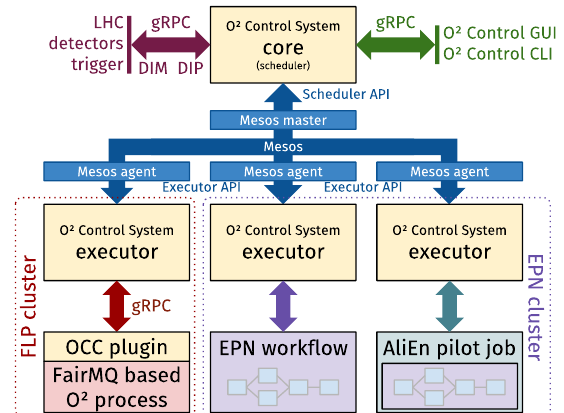
Figure 2. O 2 control